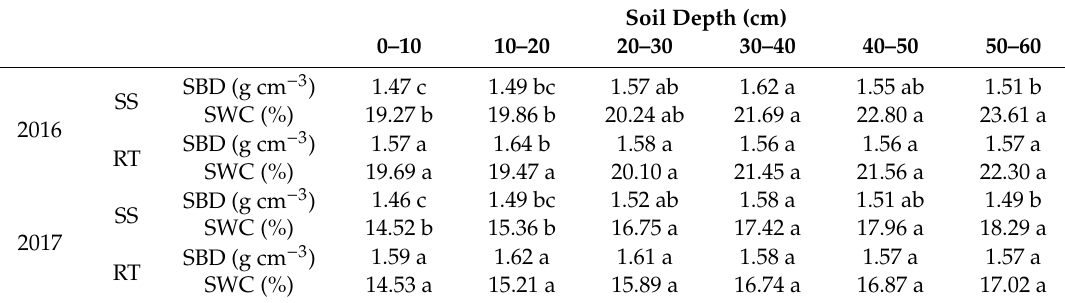
Table 3. Soil bulk density and soil water content in 2016 and